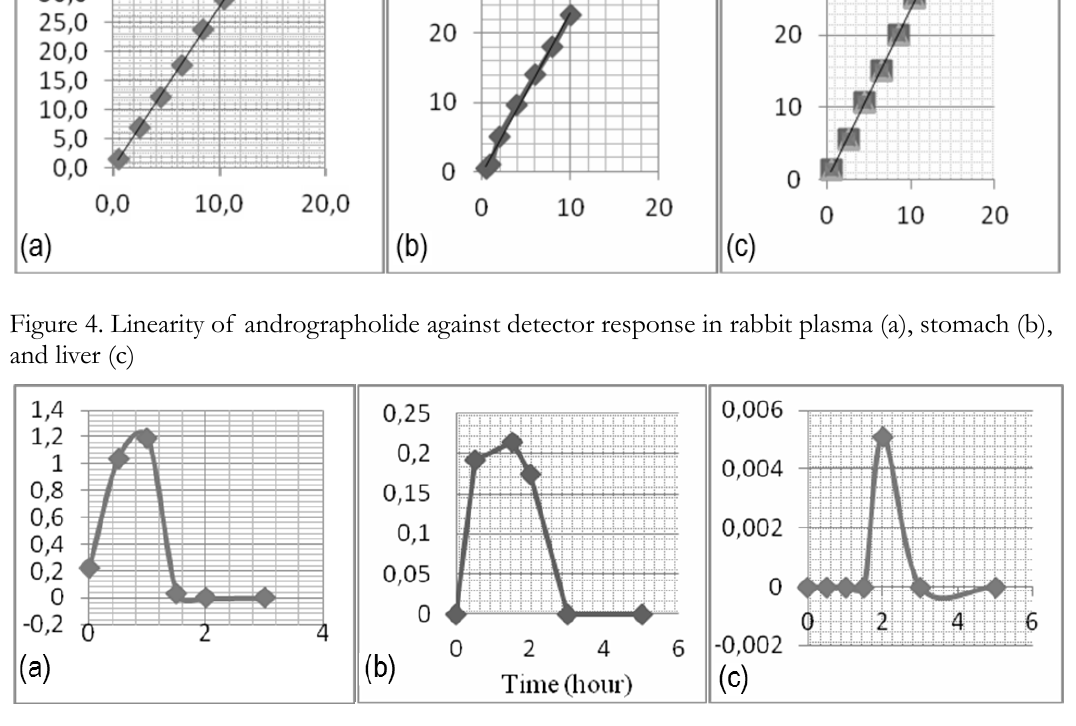
Figure 5. Pharmacokinetic profiles of andrographolide in rabbit plasma (a), stomach (b), liver (c) Table I. Optimization of HPLC system